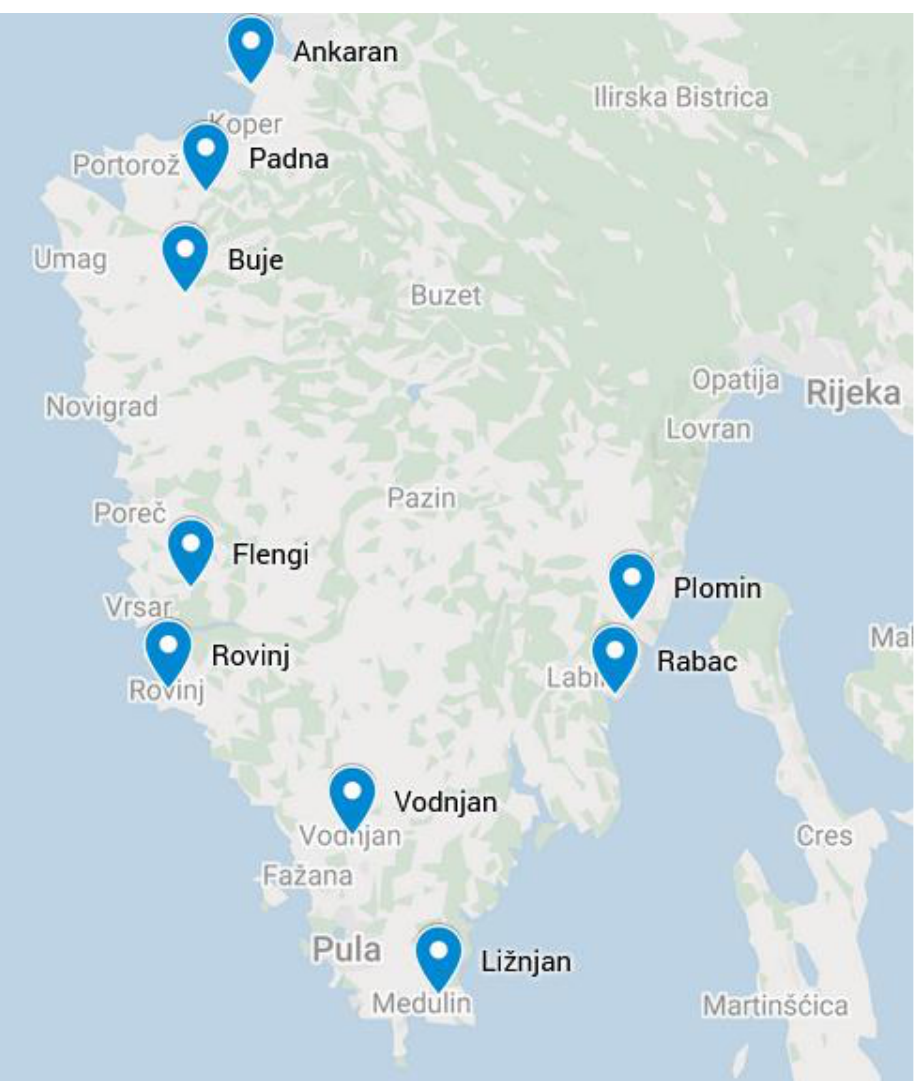
Figure 4. Geographic locations of fennel populations in study in Istria. Retrieved from GoogleMaps.